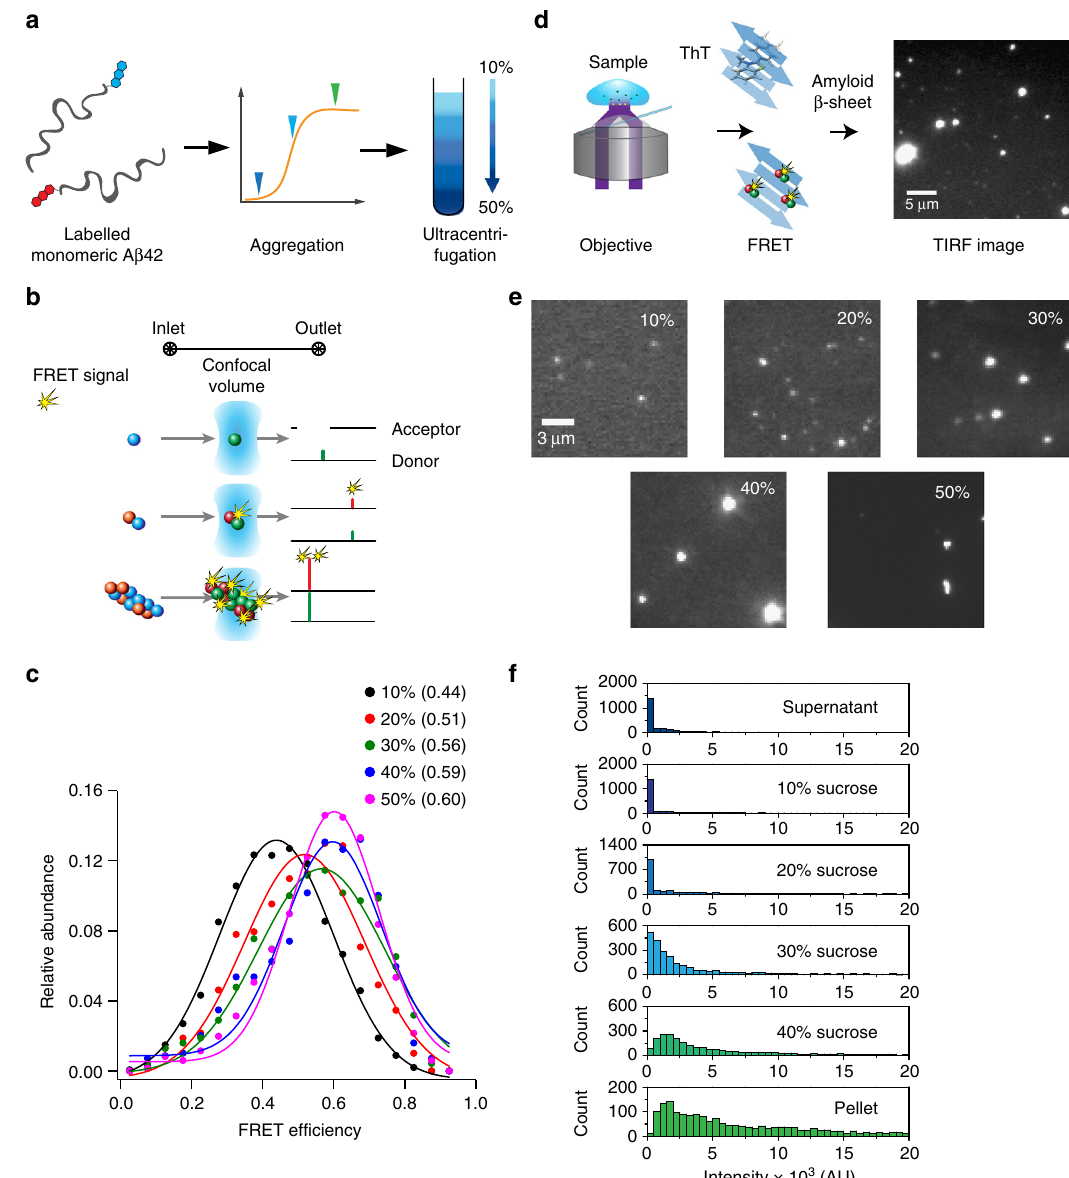
Fig. 5 Single-particle characterization of the dye-labelled Aß42 aggregates, a Schematic representation of the separation work fl ow of the A β 42 aggregates: solutions of dye-labelled monomeric A β 42 were allowed to aggregate and aliquots removed at the different times described in Fig. 2 (shown as coloured triangles in the graph). The aggregated mixture collected at different time points was then loaded onto a sucrose step gradient that is divided into fi ve fractions, and was subsequently used for experimental measurements. b Illustration of the confocal FRET experiment, showing a schematic of the micro fl uidic channel used to deliver the samples for measurement. The confocal volume of the excitation beam was set to the centre of the channel. Both the donor and acceptor channel intensities were recorded for every aggregate fl owing through the excitation volume. c Maxima of FRET ef fi ciency for increasing sucrose concentrations shifts towards higher FRET ef fi ciencies indicates that size of the aggregates present in sucrose solution increases. Relative FRET ef fi ciency for each sucrose concentration are fi tted with Gaussian function (solid lines) to get the maxima (shown in parenthesis). d Schematic of the TIRF imaging for single-aggregate imaging. e Images of aggregates present in all fi ve fractions are shown to represent the sizes detected through TIRF microscopy and are representative of the indicated fractions. The scale bar is 3 µ m. The FRET histograms of the fractions show a clear shift from a very narrow, low-intensity distribution in the smaller fractions to a broader higher intensity distribution in the higher fractions and in the pellet. Each histogram is the sum of aggregates of 27 fi eld of views measured in three repeats of a single gradient ultracentrifugation preparation. Source data of c and e are provided as a Source Data fi Single vesicle based membrane permeabilization assay . Vesicles with average using ε 280 = 1490 L/molcm. Aliquots of monomeric A β 42 were diluted with diameter of 200nm were prepared by fi ve freeze and thaw cycles combined with SSPE buffer to a concentration of 2 µM in low-binding Eppendorf tubes on ice. extrusion as previously described 19 . Brie fl y, 16:0 – 18:1 PC (10 mg/mL) and Individual samples were then pipetted into multiple wells of a 96-well half-area plate (Corning 3881) and the plate was placed into an incubator at 37°C, under 18:1 – 12:0 Biotin PC (1 mg/mL) (Avanti Lipids) were mixed with 100:1 ratio. The quiescent conditions. Aliquots for measurements were then taken at ~15min lipid mixture was then hydrated in HEPES buffer (50 mM, pH 6.5) with 100 µM (early aggregates) and ~30min (late aggregates) after the plate was placed in the Cal-520 (Stratech). Freeze and thaw cycles were performed using a water bath and incubator. dry ice to get the unilamellarity. The lipid solution was extruded at least for 10